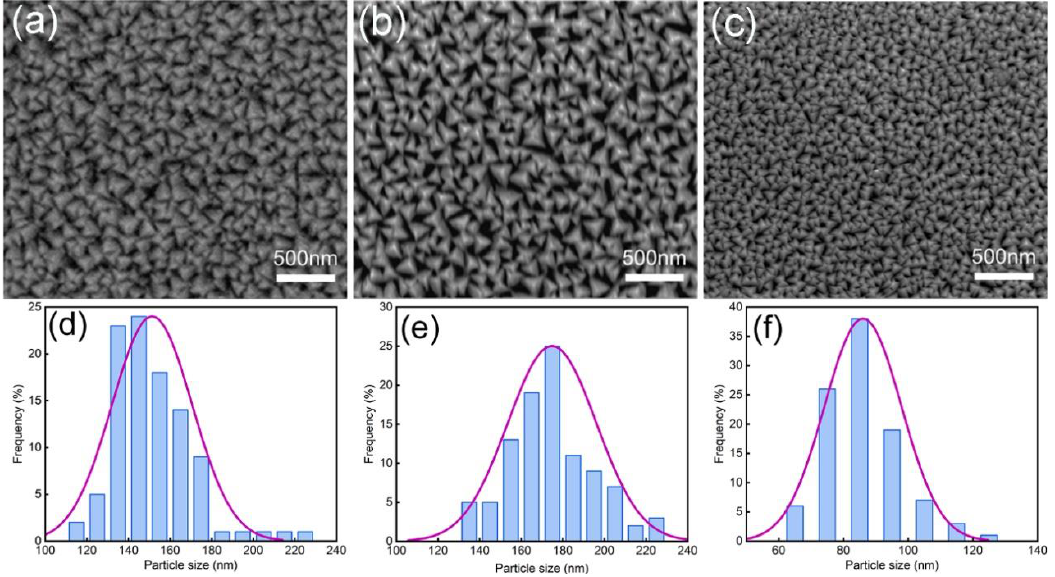
Figure 4. FESEM images of surface morphology and grain size of the Ta coatings. ( a , d ) 200 °C-175 W, ( b , e ) 300 °C-150 W, and ( c , f ) 400 °C-100 W. ( b , e ) 300 ◦ C-150 W, and ( c , f ) 400 ◦ C-100 W.